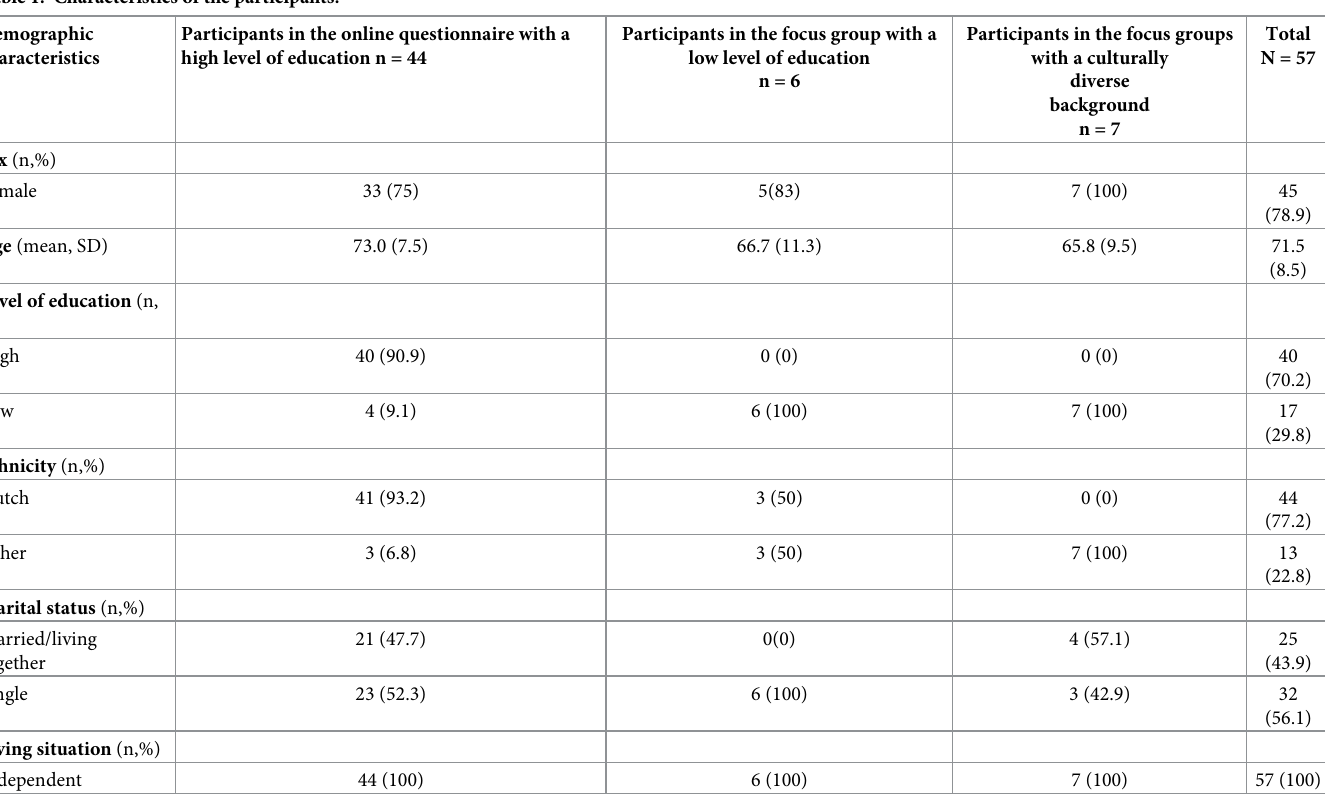
Table 1. Characteristics of the